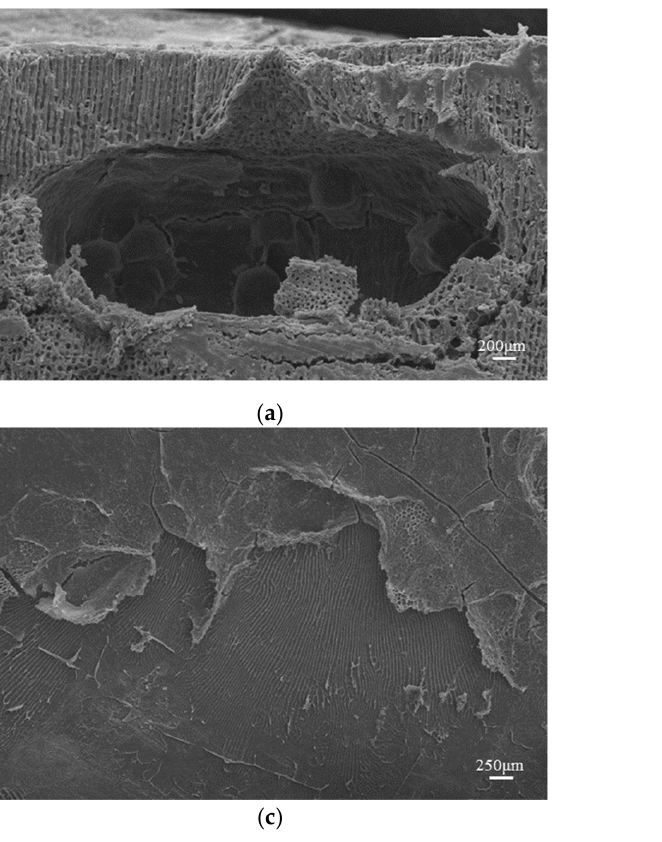
Figure 2. ( a ) SEM images of the conceptacles of coralline algae ( × 250), ( b ) the cross section of the limpet shell with coralline algae ( × 100), ( c ) the in-plane section of the limpet shell after the coralline algae had been removed deliberately ( × 180), and ( d ) the in-plane section of limpet shell with no coralline algae ( × 180). The dashed yellow line indicates the boundary line between the shell and coralline algae and the white arrows indicate irregular holes.